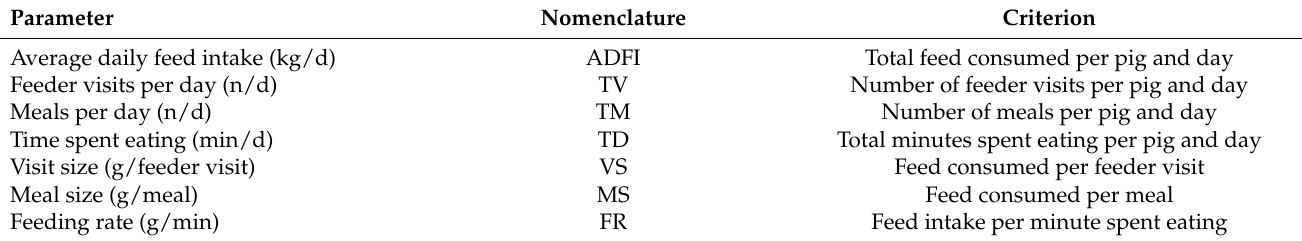
Table 1. Individual feeding behaviour parameters and the criteria used to compute